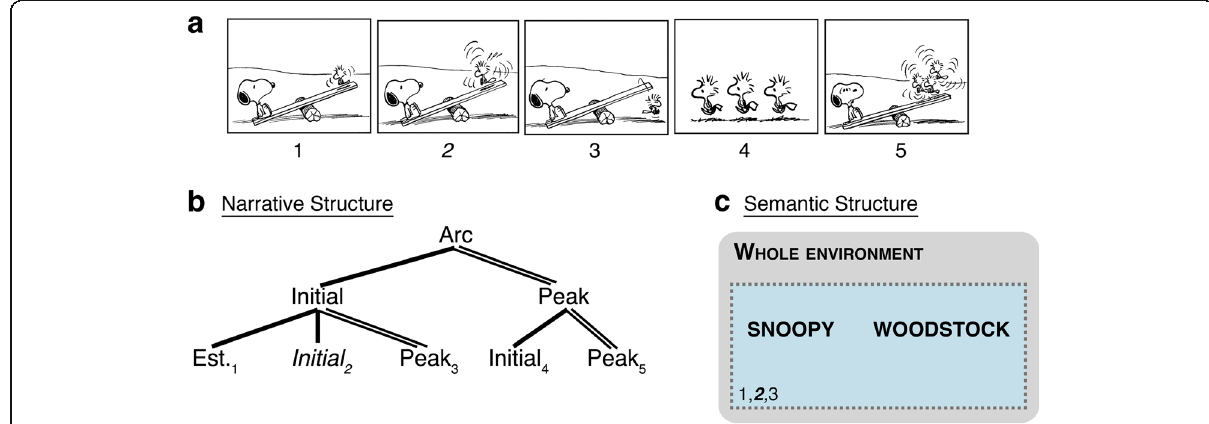
Fig. 1 ( a ) Visual narrative sequence that uses ( b ) a simple hierarchic narrative structure which ( c ) maps to a spatial semantic